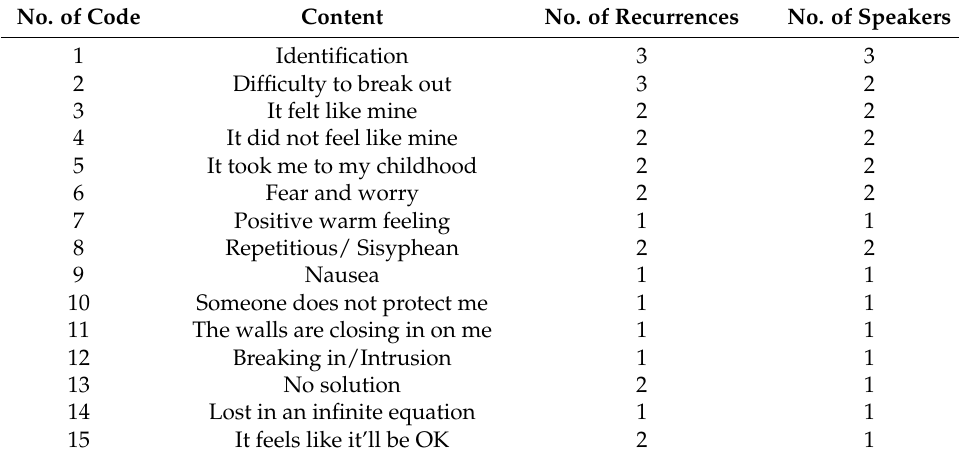
Table A2. Category B: Emotional experiences.